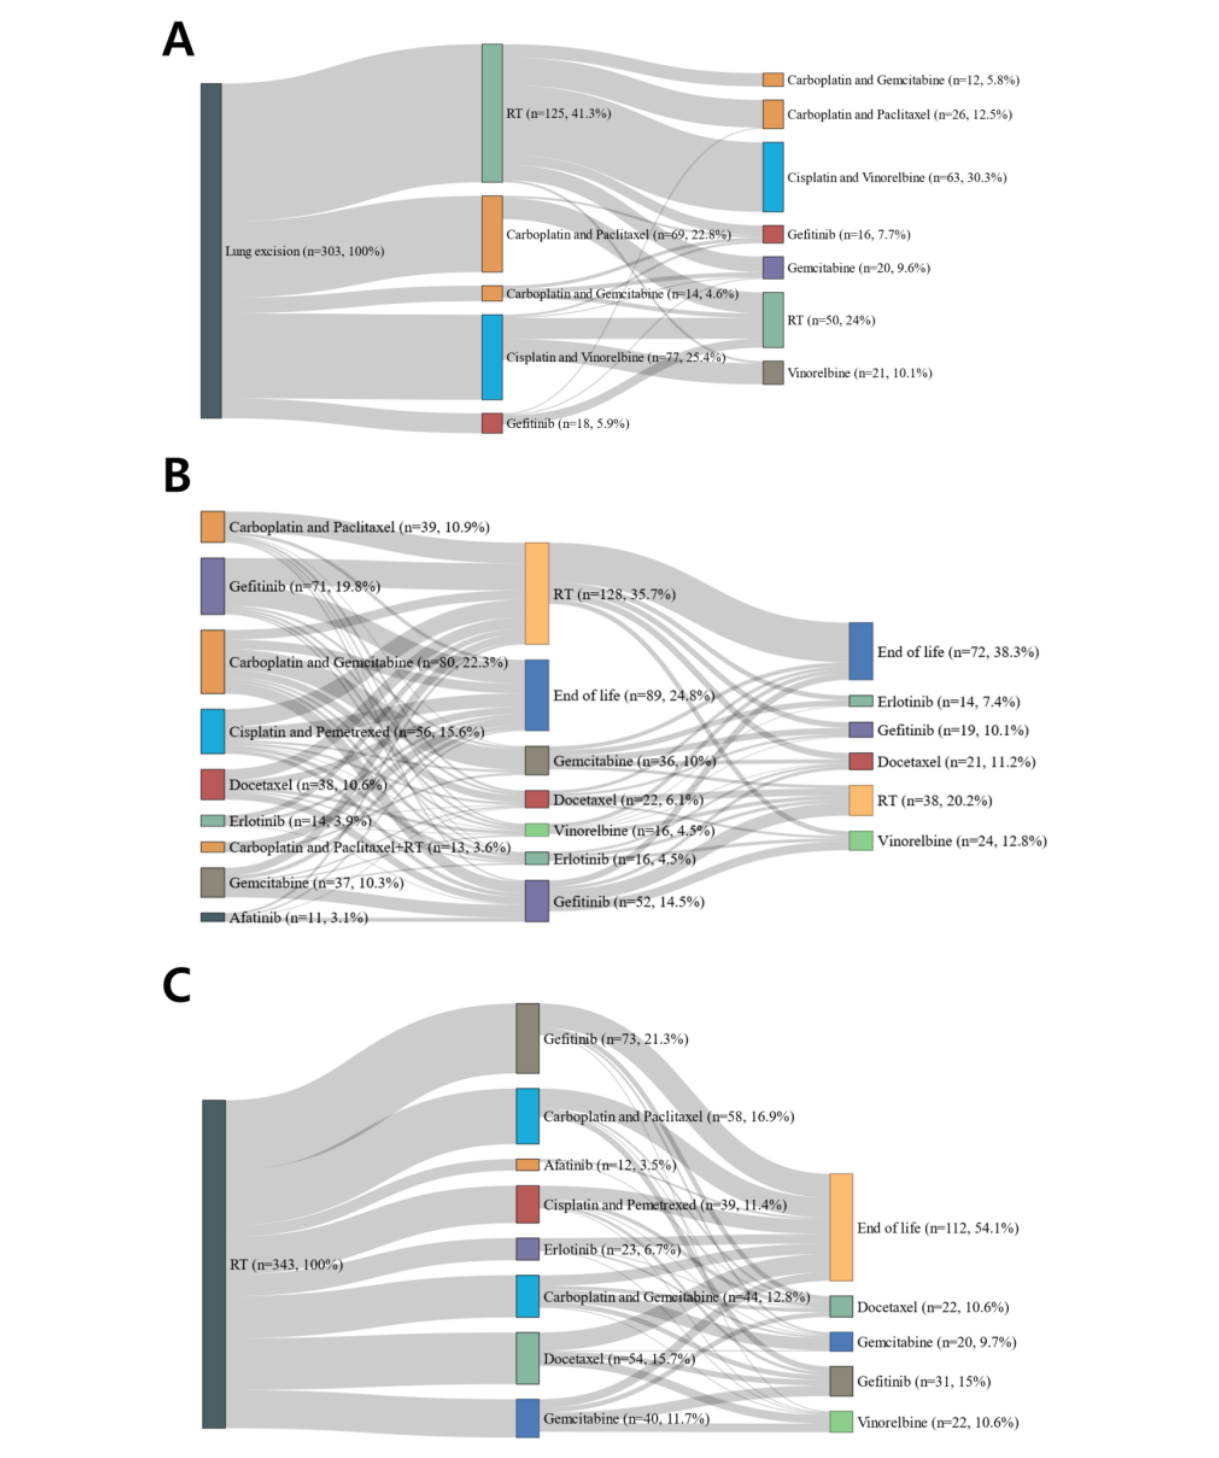
Figure 5. Anticancer treatment trajectories of patients with lung cancer in the Ajou University School of Medicine database. The treatment trajectories of patients with lung cancer were classified according to the type of first-line treatment: (A) surgery, (B) chemotherapy or chemotherapy with radiation, and (C) radiation therapy. The height of each node represents the population of patients in the corresponding treatment line or therapy. The number of patients who progressed to the next line of treatment is illustrated using gray lines. The chemotherapy regimen changes or the transition between types of treatment were regarded as a treatment line transition. The percentage on the label covers the proportion of the number of patients to all patients in the identical line of trajectory. As the large number of nodes hinders the purpose of the visualizations within a graphical summary, the nodes are truncated at the third node. For the same reason, the nodes for patient count under 10 were removed. AUSOM: Ajou University School of Medicine; RT: radiation